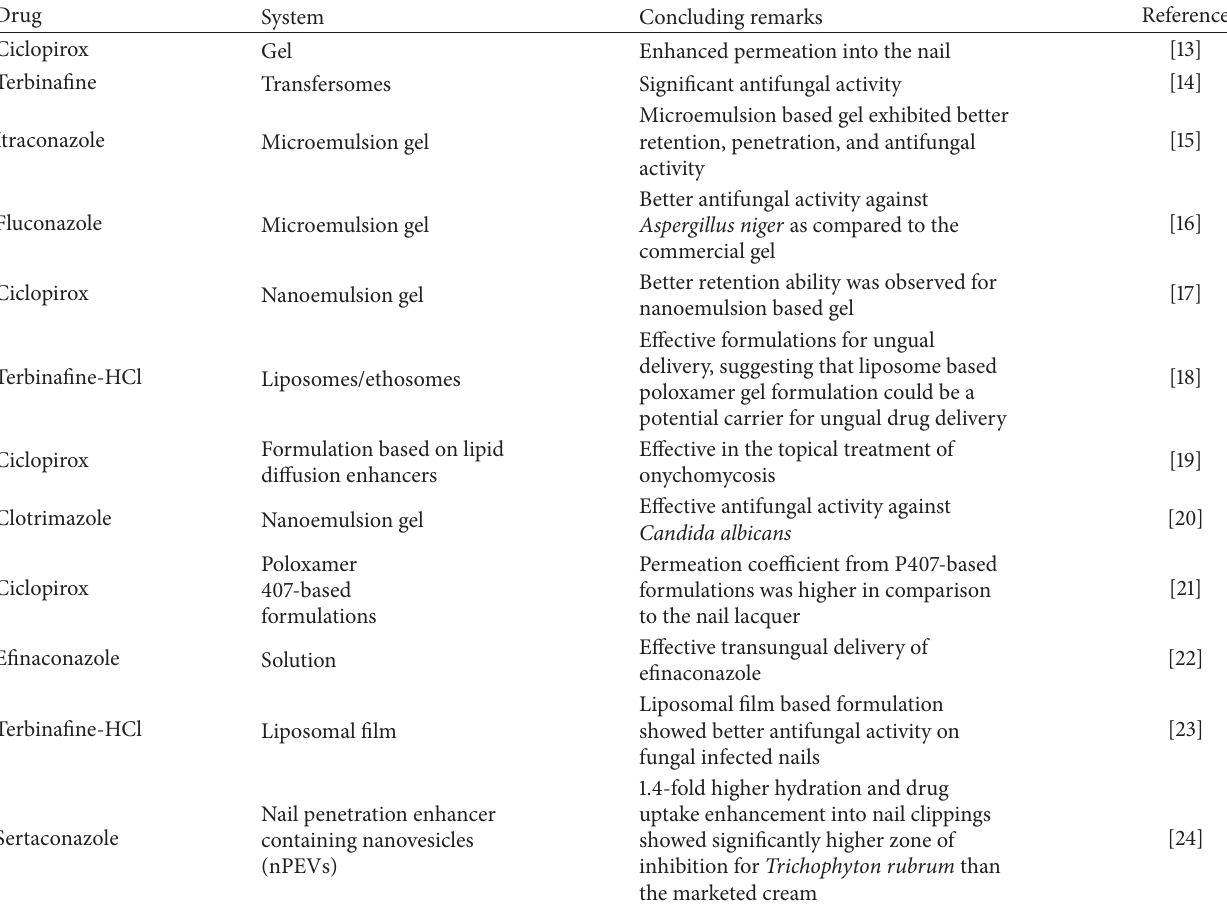
Figure 2: Mechanism of drug penetration via nail lacquers. Table 3: Topical drug delivery via several other carriers for the treatment of